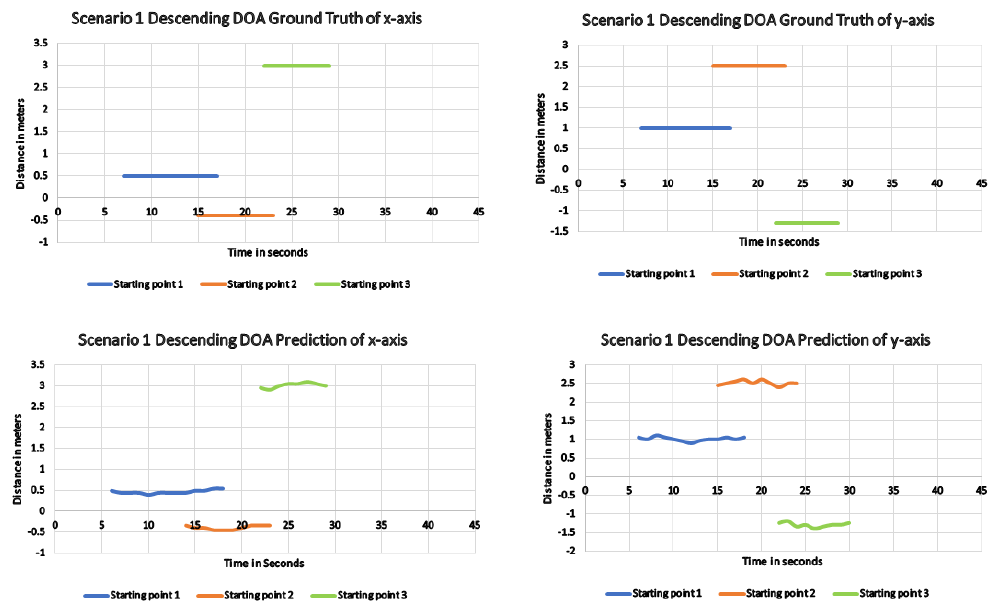
Figure 9. DOA result for the proposed method showing the difference in the actual and predicted x, y coordinates of scenario 1 descending direction.